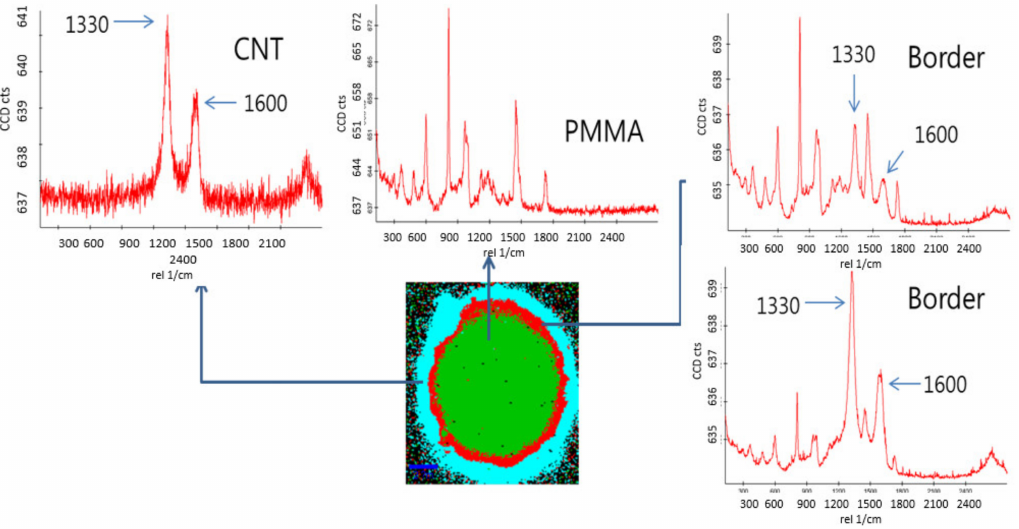
Figure 3. Raman micrographs of MWCNT-coated PMMA bead with Raman spectrum of PMMA, CNT, and